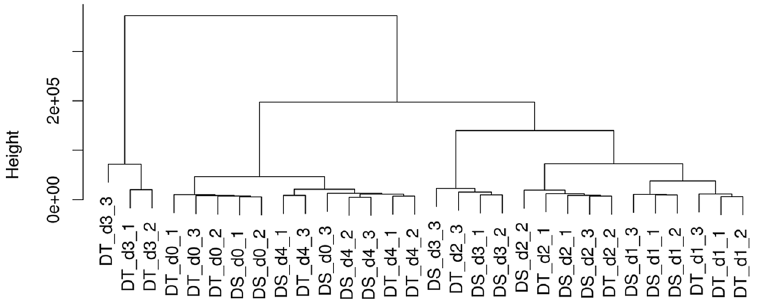
Figure 5. Dendrogram showing correlation among the different samples based on global expression profiles in the drought tolerant (DT) and sensitive (DS) genotypes. d 0 , d 1 , d 2 , d 3 and d 4 : plants stressed for 0, 3, 7, 11 days and 3 days of recovery after rewatering,